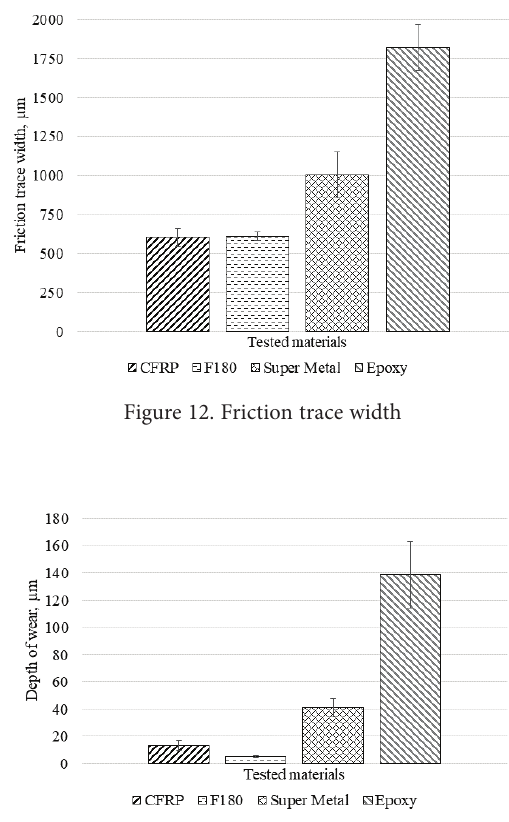
Figure 13. Depth of